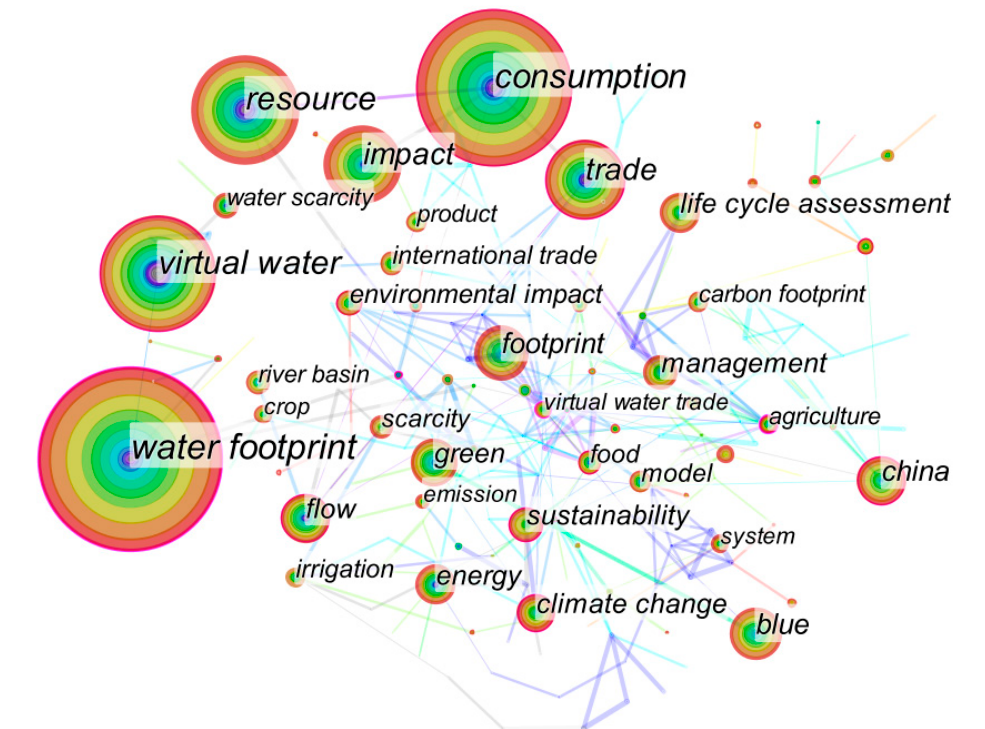
Figure 6. Keywords with a frequency of more than 50.